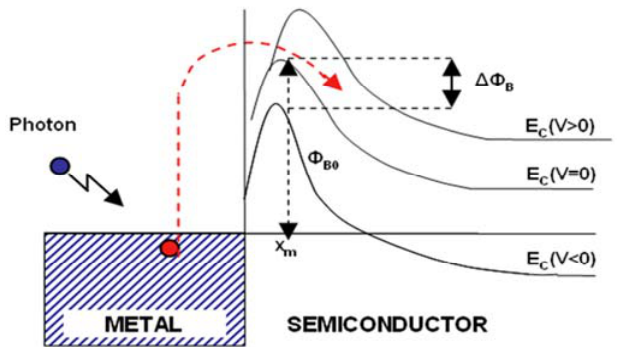
Figure 3. Energy band diagram for a metal/n-semiconductor junction. Reprinted with permission from M. Casalino et al. [29] IOP Publishing is